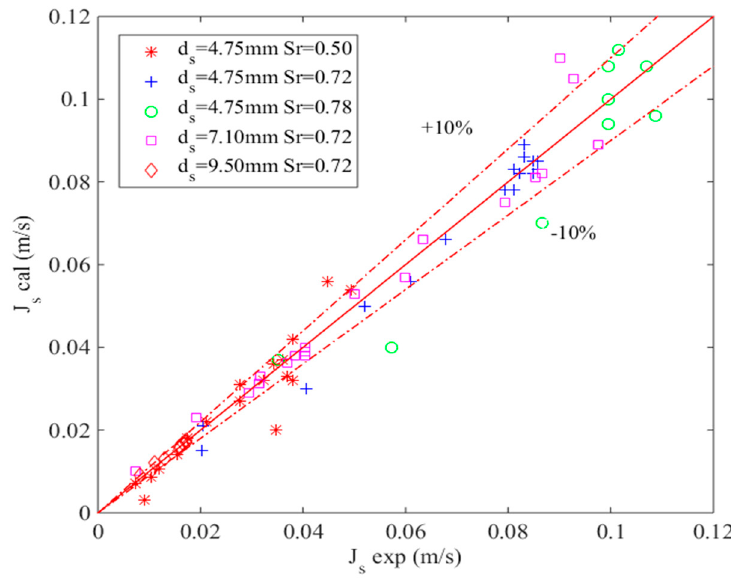
Figure 3. Validation results by experimental data from Kassab et al [3].